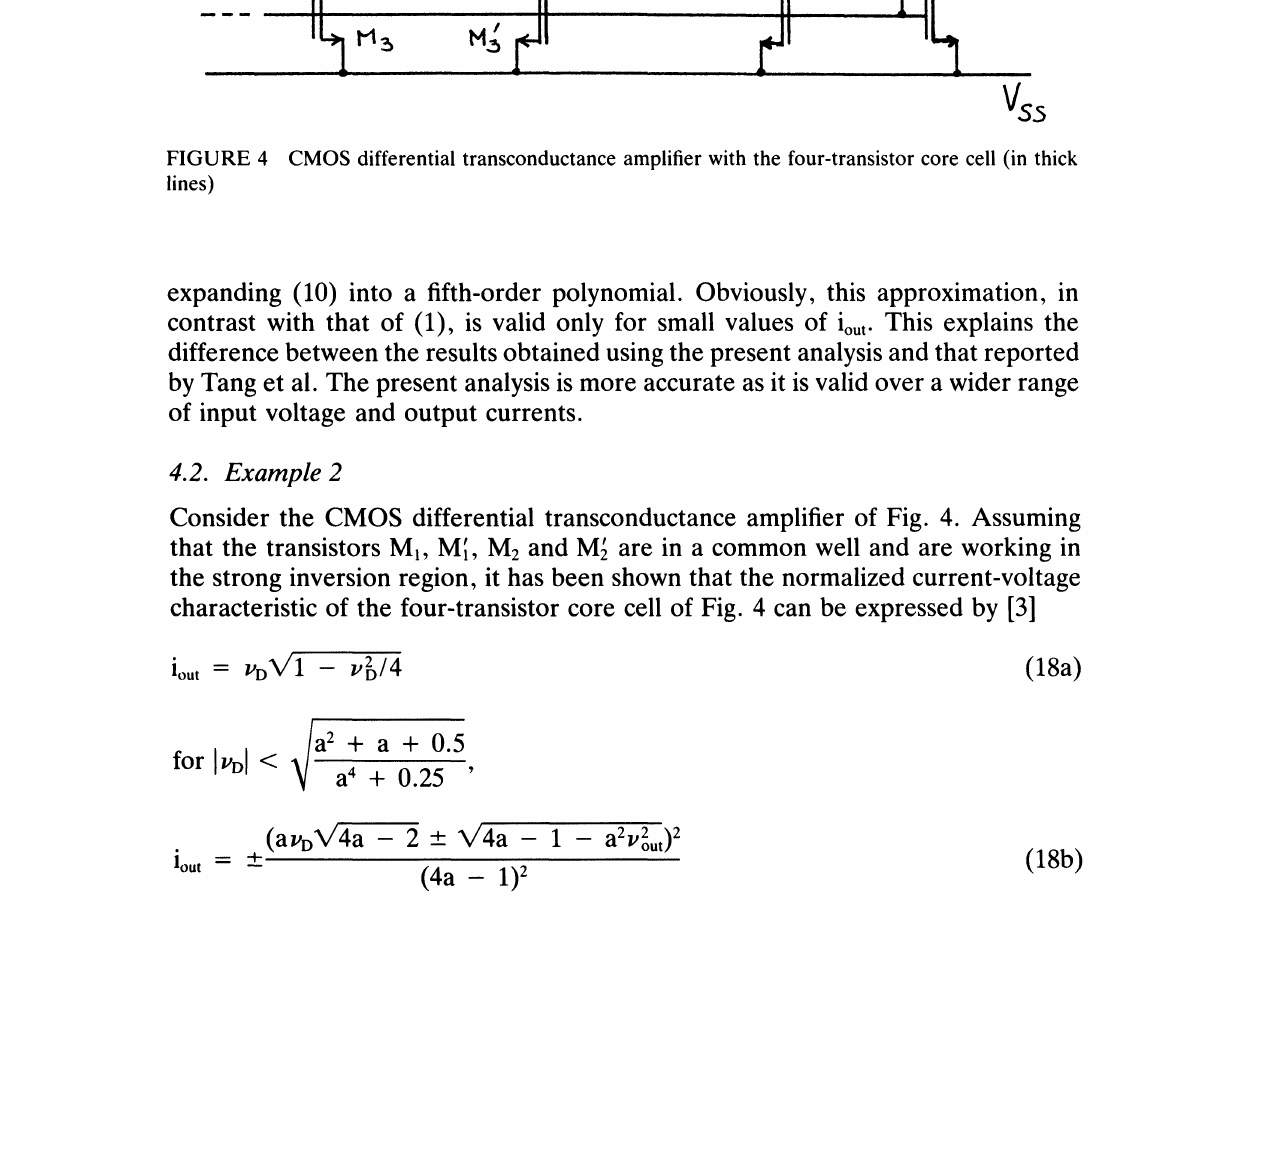
CMOS differential transconductance amplifier with the four-transistor core cell (in thick lines)